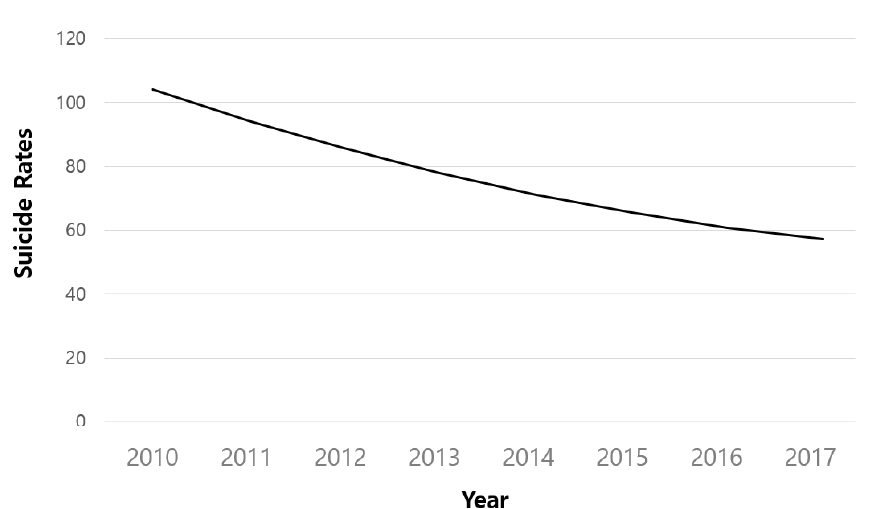
Figure 4. Quadratic function estimate of the older adult suicide rate 3.2. Analysis of the study model.